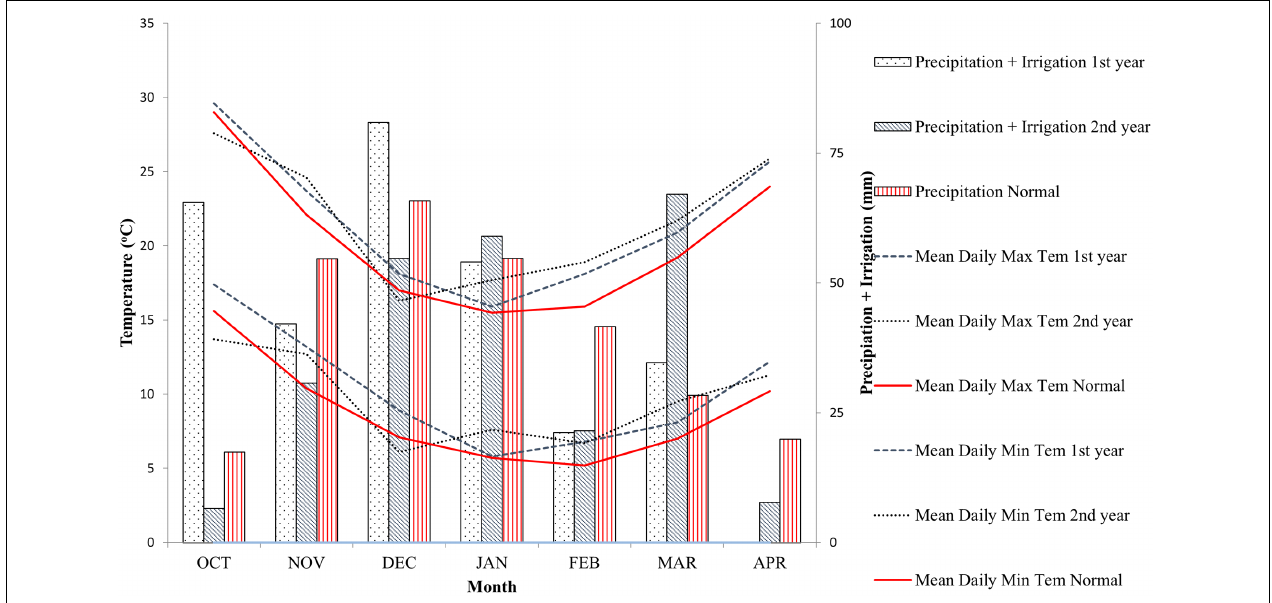
FIGURE 1 | Environmental conditions during the test years and normal conditions at Athalassa experimental station.